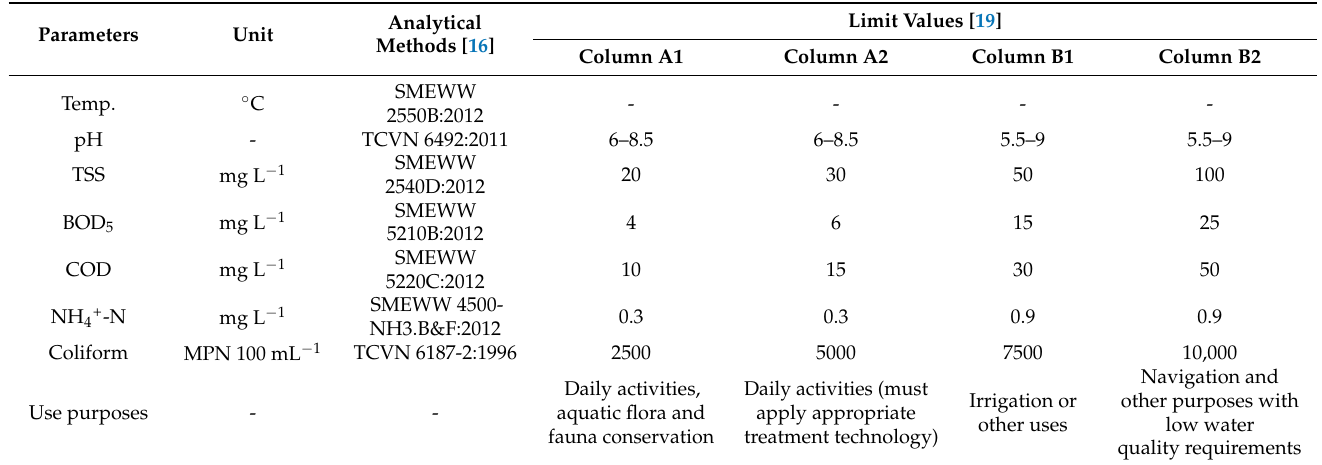
Table 1. Methods of analysis and allowable limits of surface water